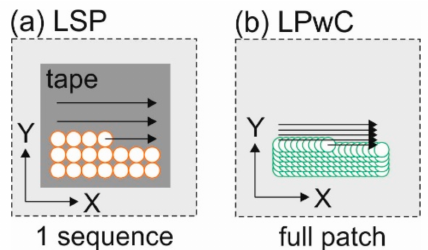
Figure 3. Peening strategies used: ( a ) LSP sequencing when protective coating is used and ( b ) LPwC single pass for the whole patch in the absence of